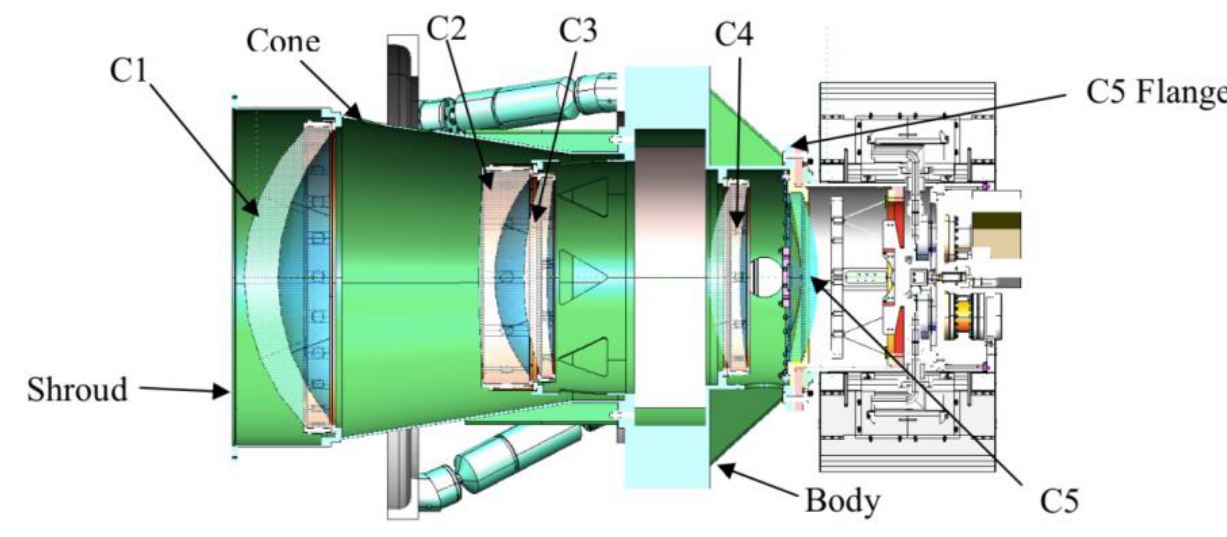
Table 2. The dimensions of DECam’s corrector lenses.